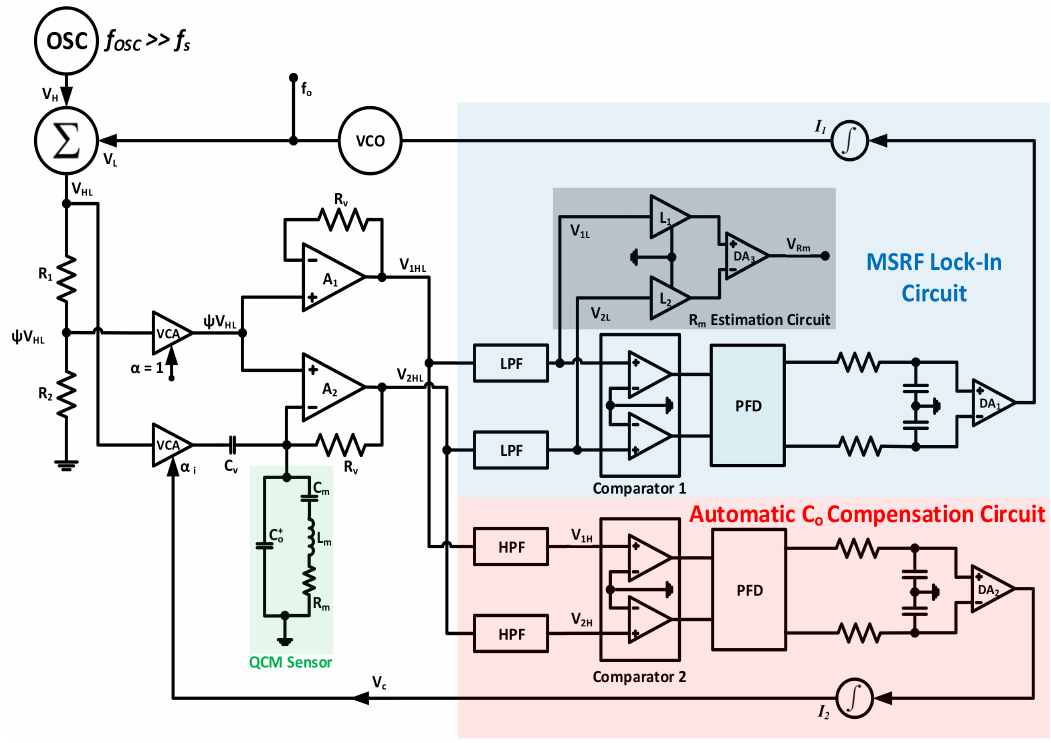
Figure 18. Zero-phase frequency lock-in system with automatic Co compensation, from